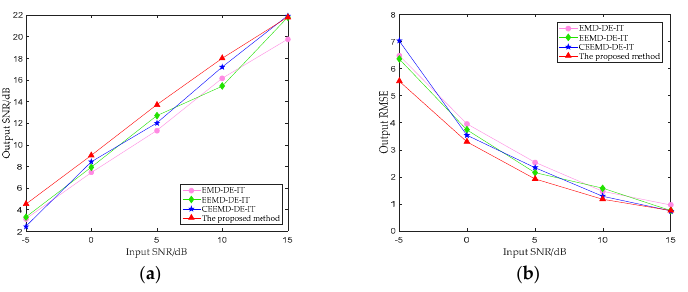
Figure 11. ( a ) SNR comparison among different methods; and ( b ) RMSE comparison among different methods.